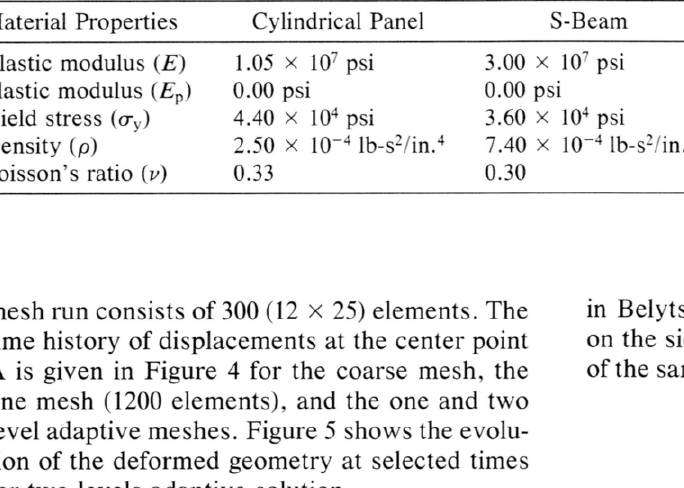
Table 3. Material Properties of Test Problems